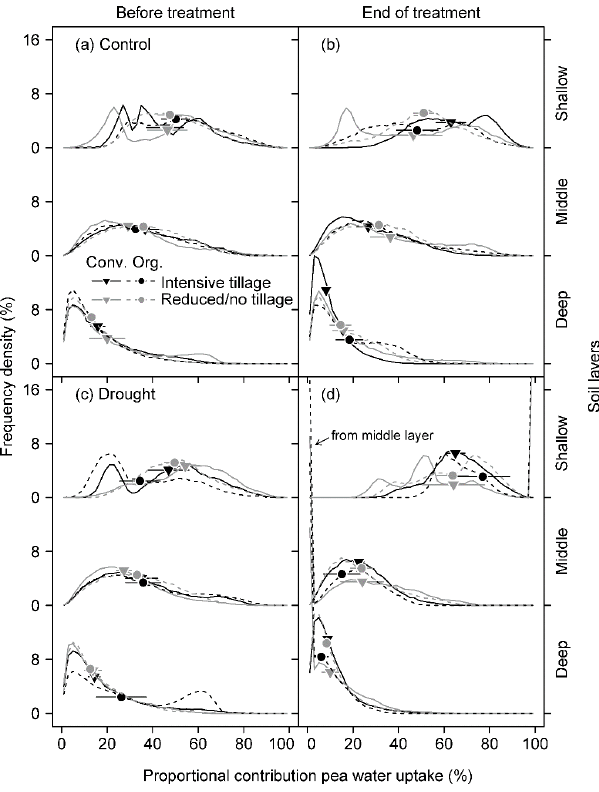
Figure 4. Frequency density distribution of model outputs on the proportional contribution of soil water to pea water uptake from the shallow (0–20cm; sum of 0–5, 5–10, and 10–20cm), middle (20–40cm; sum of 20–30 and 30–40cm), and deep (40–60cm) soil layers under different cropping systems (a, b) before the drought treatment on 7 May and (c, d) at the end of the treatment on 25 June 2018. Frequency density was derived from 10000 simu- lations at a 2% increment of mixing models using δ 18 O for each subplot (Conv. for conventional and Org. for organic). Data were pooled for all subplots in each cropping system. Symbols on the curves indicate the median of the model outputs for each soil layer. Means and 1SE (horizontal bars) of each cropping system are given ( n =